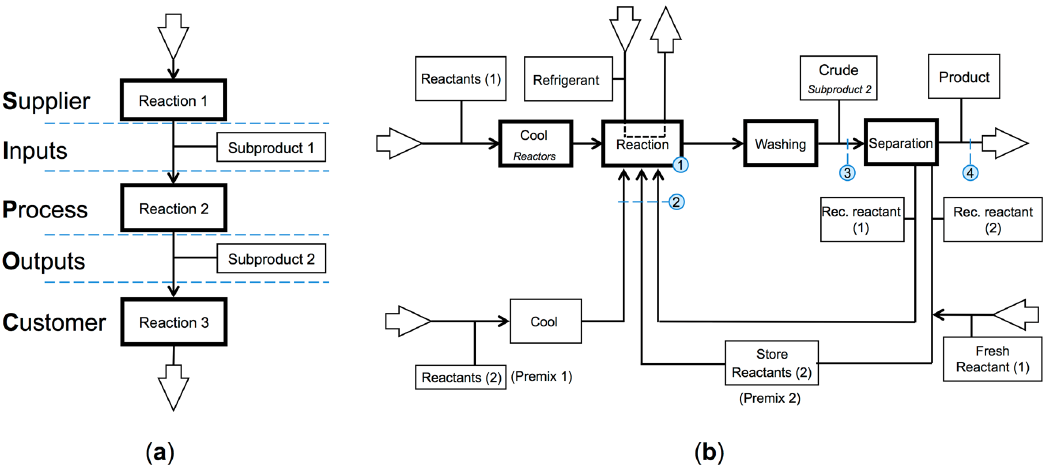
Figure 3. ( a ) ‘Suppliers, Inputs, Process, Outputs, Customers’ ( SIPOC) diagram; ( b ) simplified process block diagram for reaction 2.